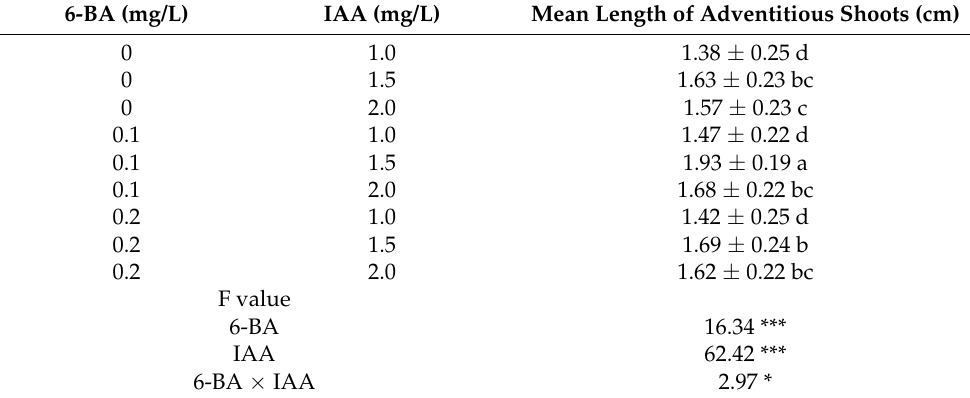
Table 9. Effect of 6-BA and IAA on adventitious shoot